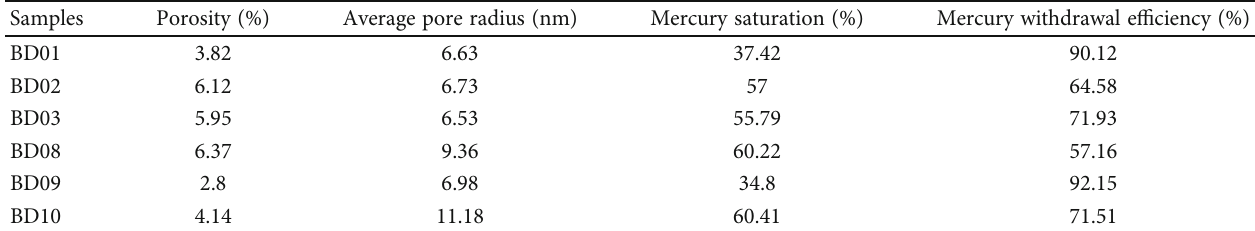
Table 3: Mercury porosimetry results of the samples.